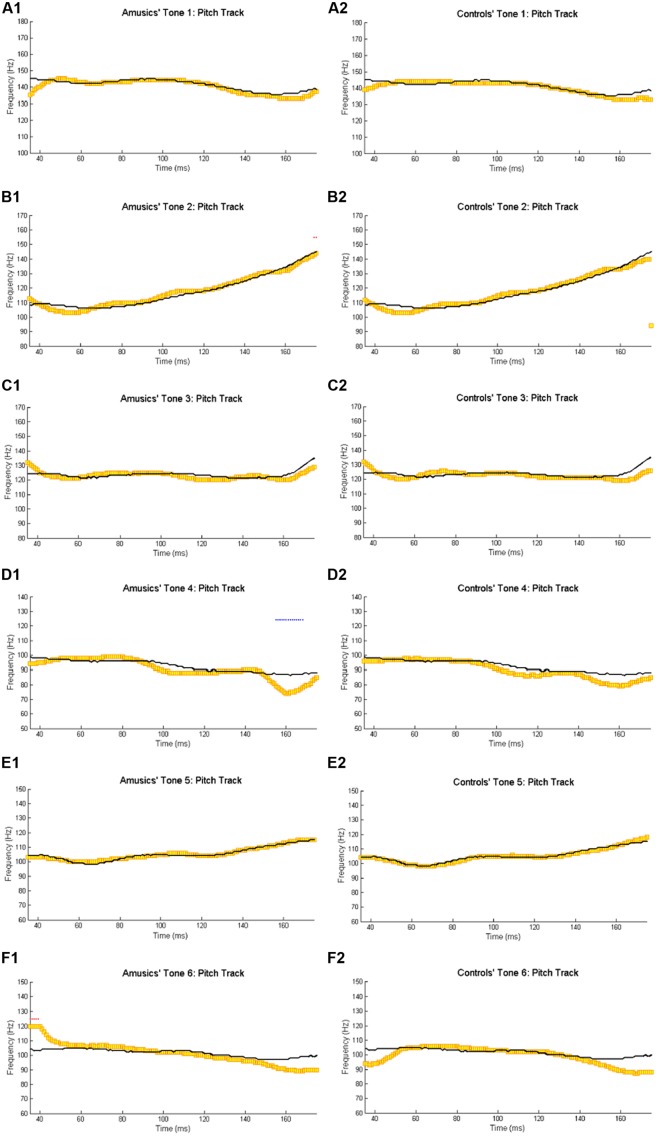
Pitch tracks of the grand-average FFRs of amusics (A1–F1) and controls (A2–F2) to the six Cantonese tones. The black and yellow lines indicate pitch tracks of the original stimuli and those of the responses, respectively. The small red dots signify regions where the extracted F0s were below the noise floor (i.e., SNR was less than one, reflecting the magnitude of the response F0), and the small blue dots indicate regions where the extracted F0s were not at the spectral maximum (indicating weak F0 encoding strengths; Song et al., 2008; Skoe et al., 2013).